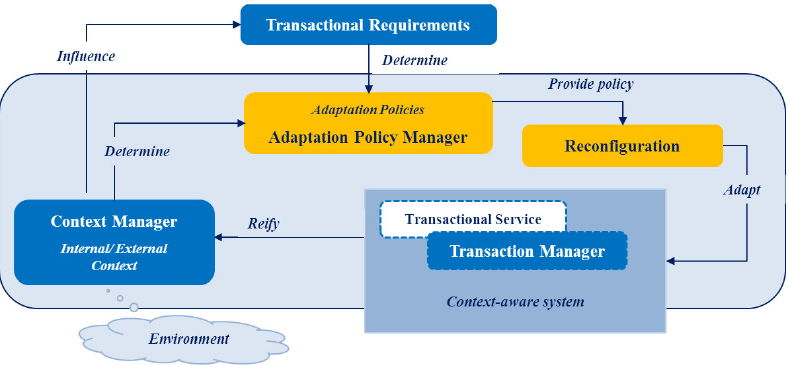
Fig. 2. Adaptation mechanism